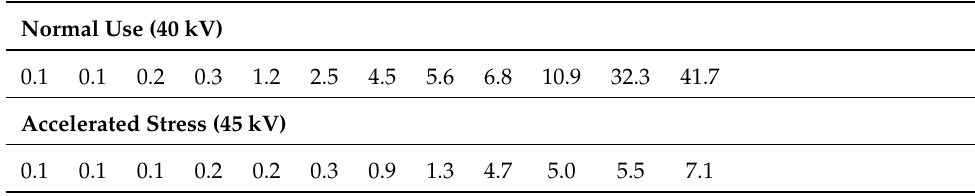
Table 1. Times to breakdown of insulating fluid.